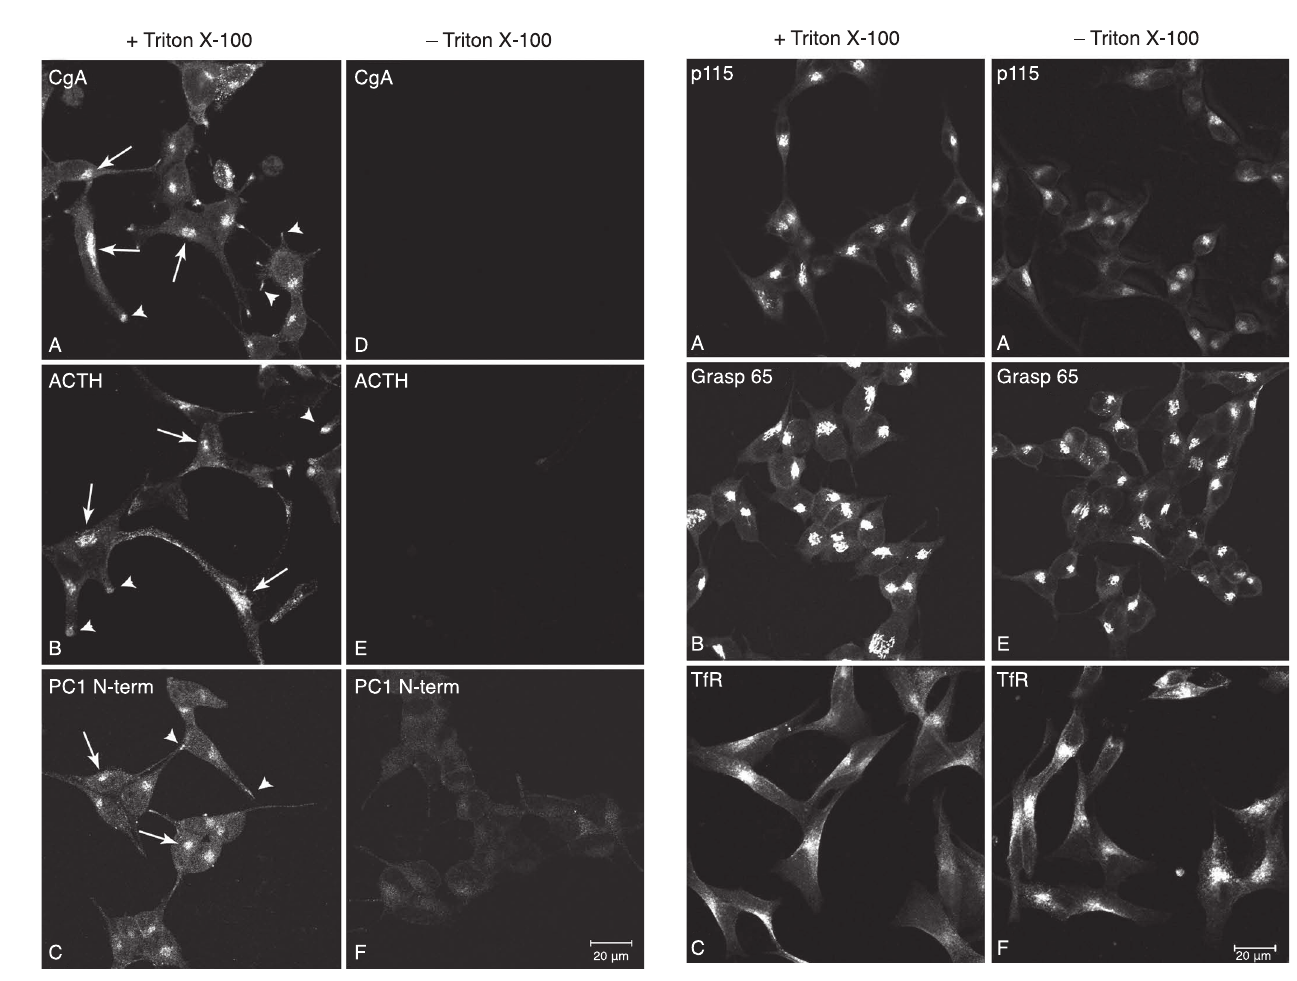
Figure 3. Immunocytochemical analysis of RSP luminal proteins in AtT20 cells. AtT20 cells were chemically fixed with 2% PFA/PBS and then treated with and without the detergent, Triton X-100. Three luminal proteins belonging to the RSP (Chromogranin A, ACTH and the N-terminus of PC1) were stained by indirect immunofluorescence. For all three proteins, the Golgi (arrows) and